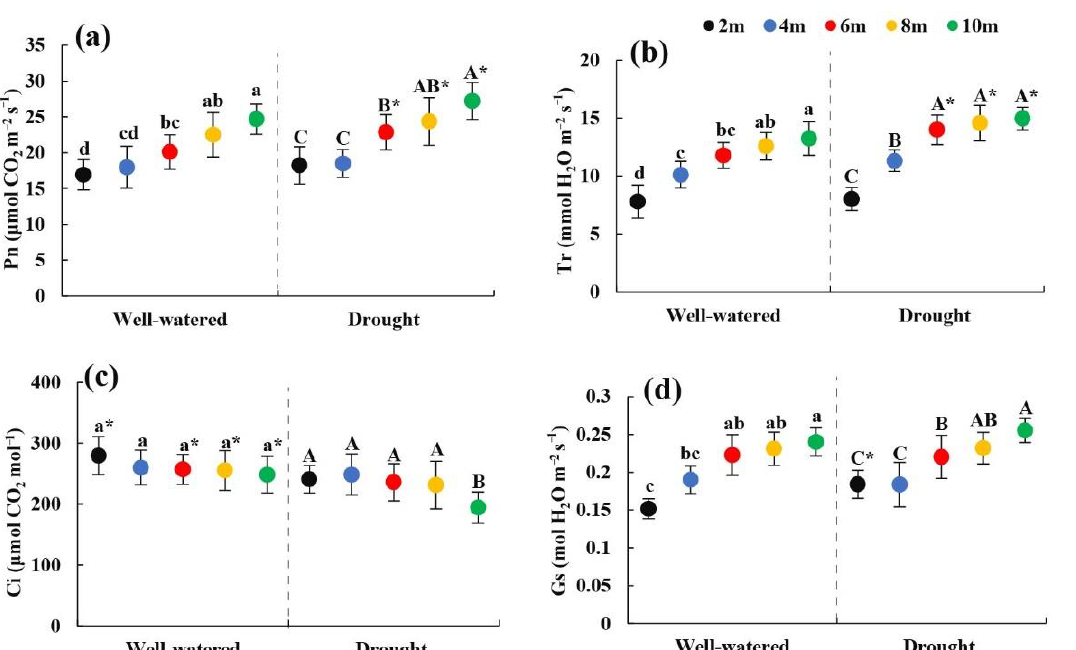
Figure 2. Changes in photosynthetic physiological parameters of heteromorphic leaves with tree height under different soil moisture conditions. Note: ( a – d ) were changes in photosynthetic rate, transpiration rate, intercellular CO 2 concentration, stomatal conductance with different tree heights under different soil moisture conditions. The black dot indicates the height of the 2 m tree, the blue dot indicates the height of the 4 m tree, the red dot indicates the height of the 6 m tree, the yellow dot indicates the height of the tree 8 m, and the green dot indicates the height of the 10 m tree; lowercase and uppercase letters represent the significance of the difference between different sampling heights under suitable soil moisture conditions and soil drought stress conditions, and * represents the comparison of the same height under different habitats ( p < 0.05). P n : photosynthetic rate; T r : transpiration rate; Gs: stomatal conductance; C i : Intercellular CO 2 concentration.